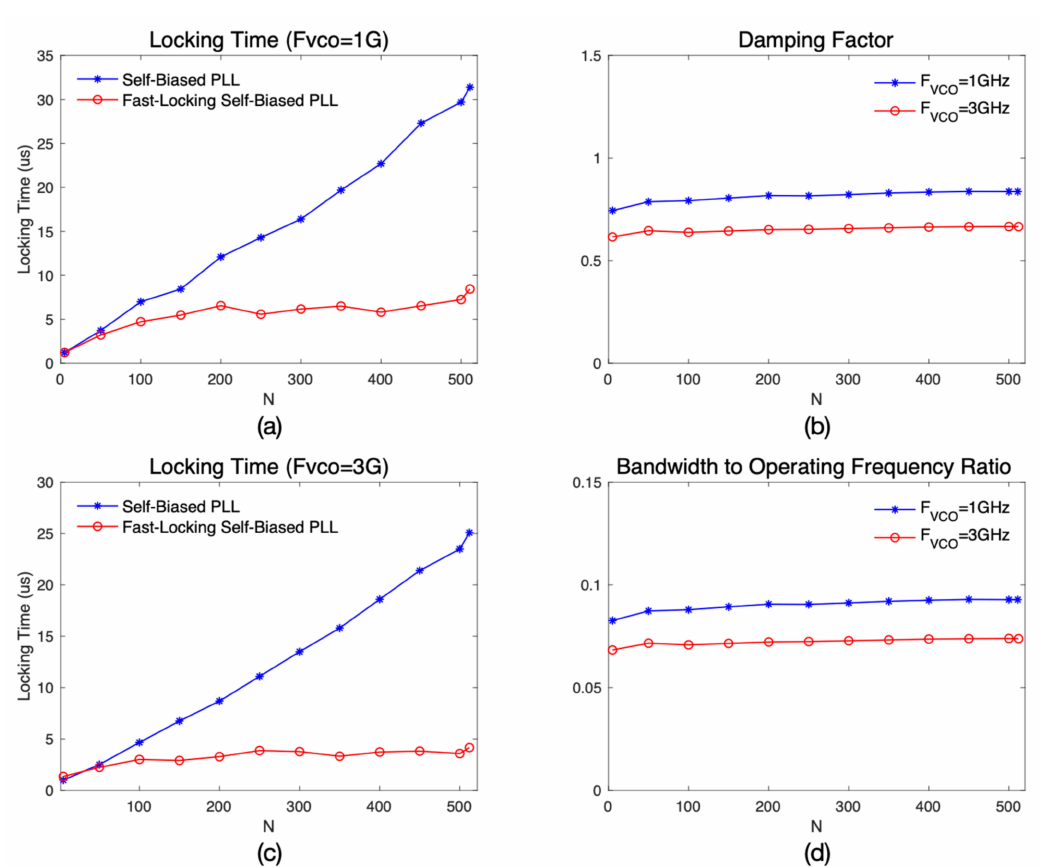
Figure 7. ( a ) Lock-in time under 1 GHz operating frequency, ( b ) ζ under 1 and 3 GHz operating frequency, ( c ) lock-in time under 3 GHz operating frequency, and ( d ) ω N / ω ref under 1 and 3 GHz operating